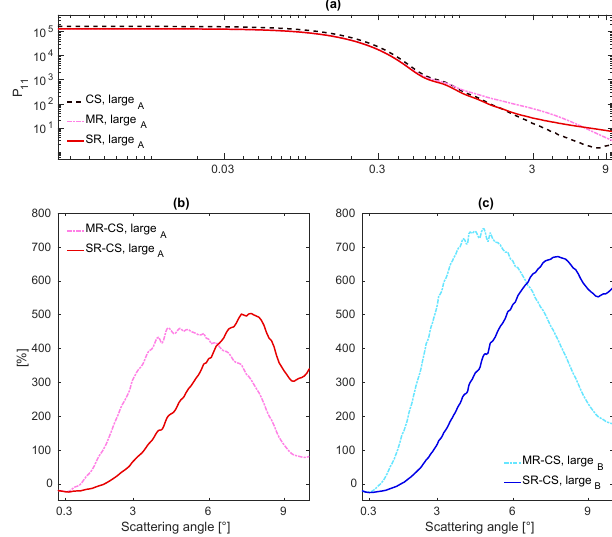
Figure 4. Sensitivity of the vertically integrated phase functions to the size-shape distribution of large severely rough ice crystals. (a) The P 11 of in situ-based distributions of flights A and B and log- normal distributions with D 0 = 100/200/400µm . (b, c) The relative differences in P 11 between the six single-habit distributions and the in situ-based distributions for flight A (left) and B (right).